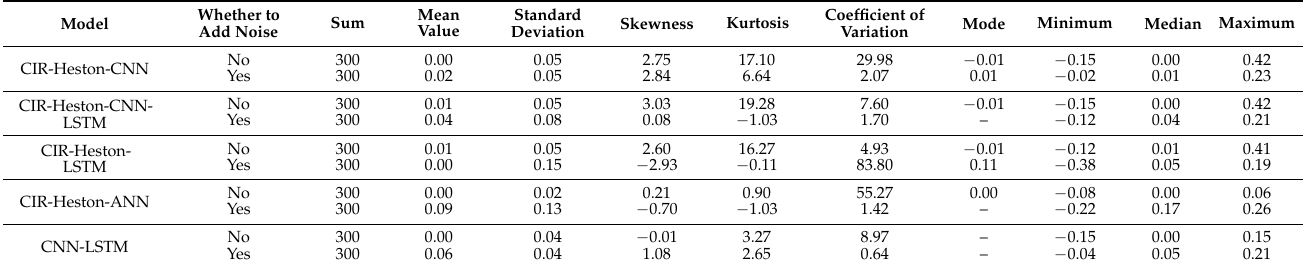
Table 9. Put option model robustness tests for the descriptive